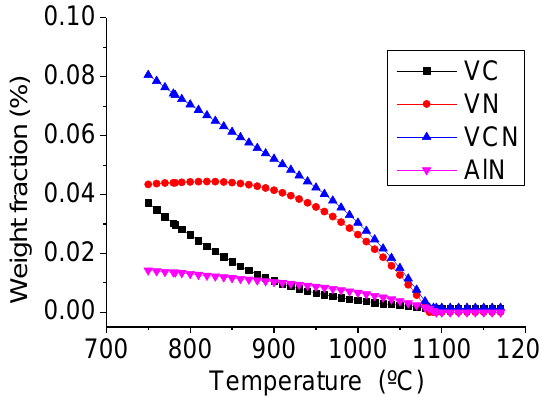
Figure 1. Equilibrium compounds predicted by FactSage.